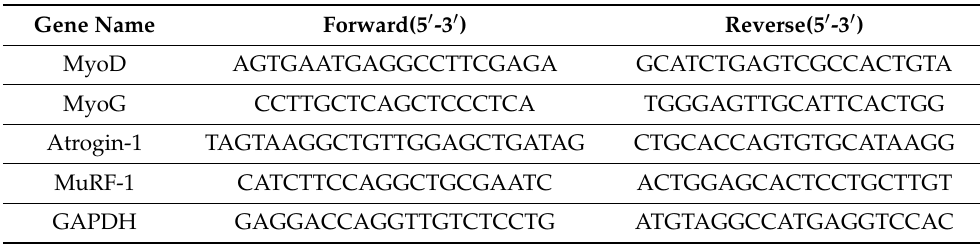
Table 1. Sequence of PCR primers used in this